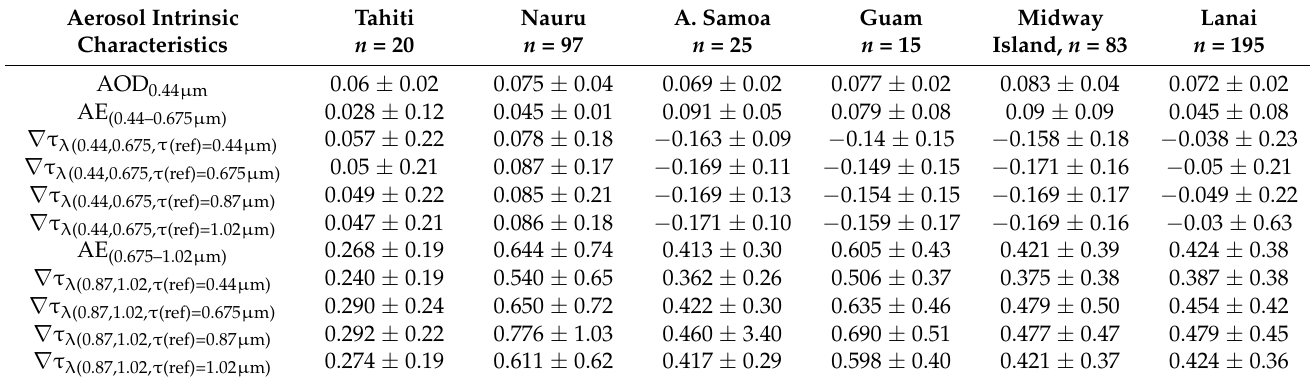
Table 4. The optical properties of sea salt aerosol (SS) from various source regions: Tahiti, Nauru, American Samoa, Guam, Midway Island, and